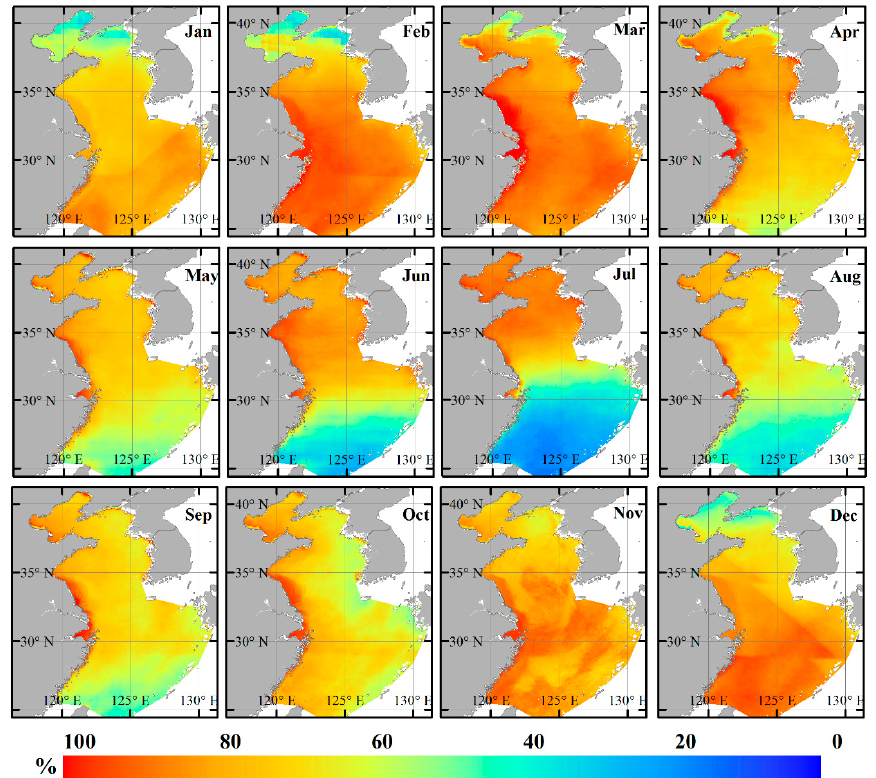
Figure 2. Monthly cloud coverage percentages for China’s seas from GOCI observations between 2013 and 2017.